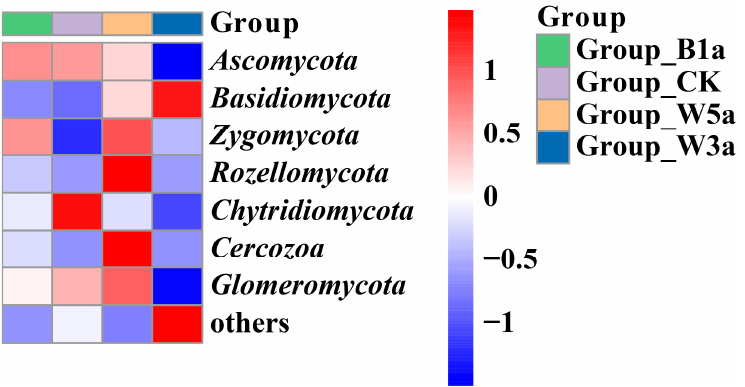
Figure 3. The composition of fungal communities at the phylum level in the casing soil of different treatments of G. leucocontextum cultivation. treatments of G. leucocontextum